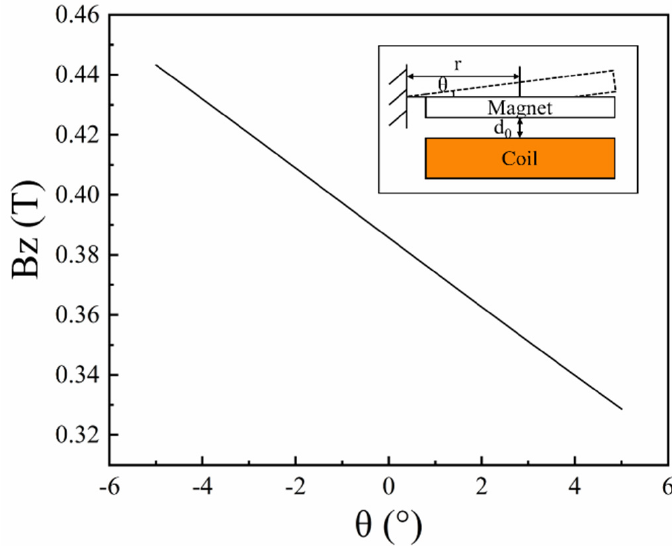
Figure 2. Curve of magnetic flux density along the z axis as a function of θ .